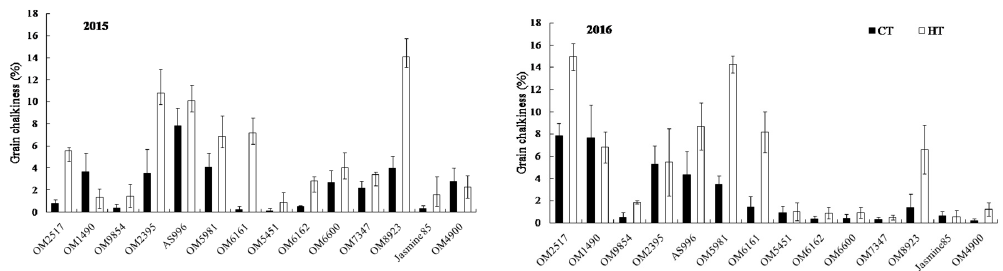
Figure 6. Effect of high temperature on the percentage of chalky grains in Vietnamese cultivars. Vertical bars indicate SD of means ( n = 3).